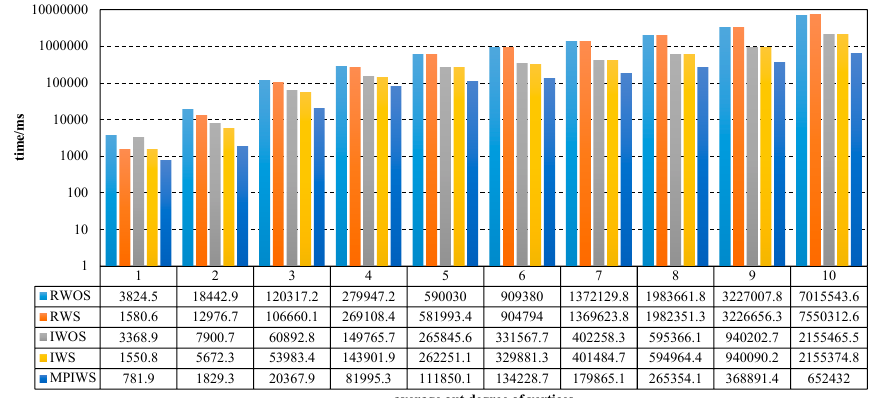
Figure 4. Impacts of average degree of vertices on execution time of each algorithm.